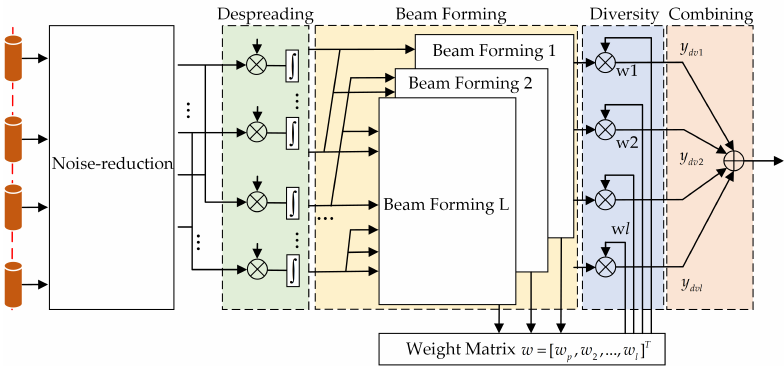
Figure 13. The structural composition of the STD model based on the weight update